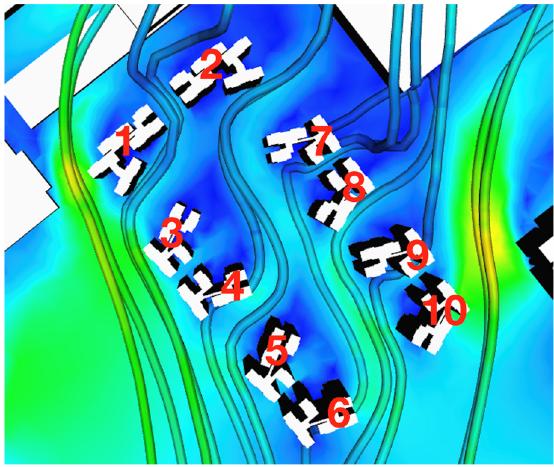
Figure 20. Modular buildings marker.